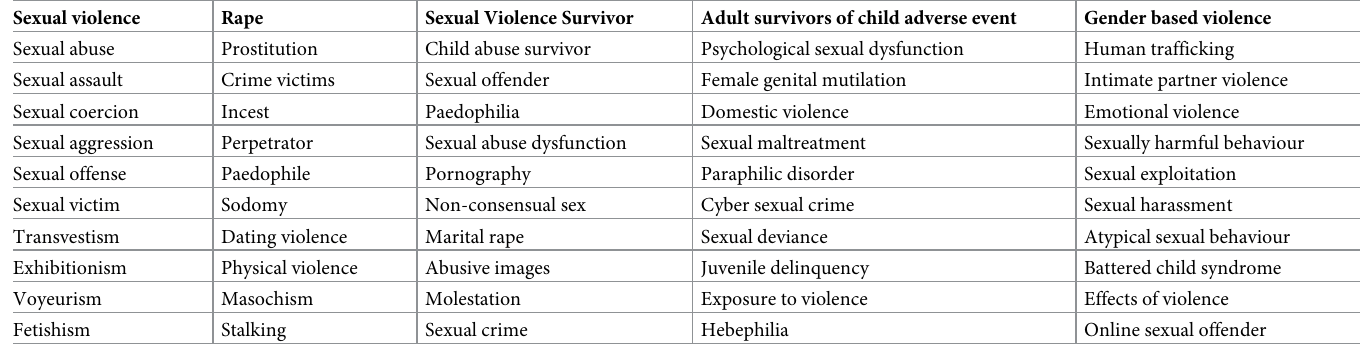
Table 1. Search terms paired with